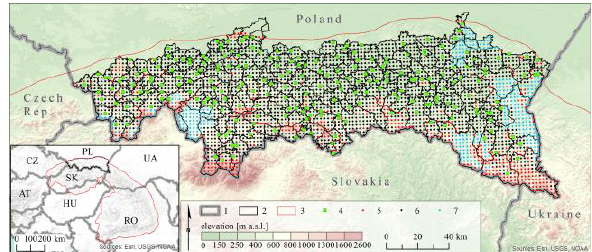
Figure 1. Study area, availability and spatial distribution